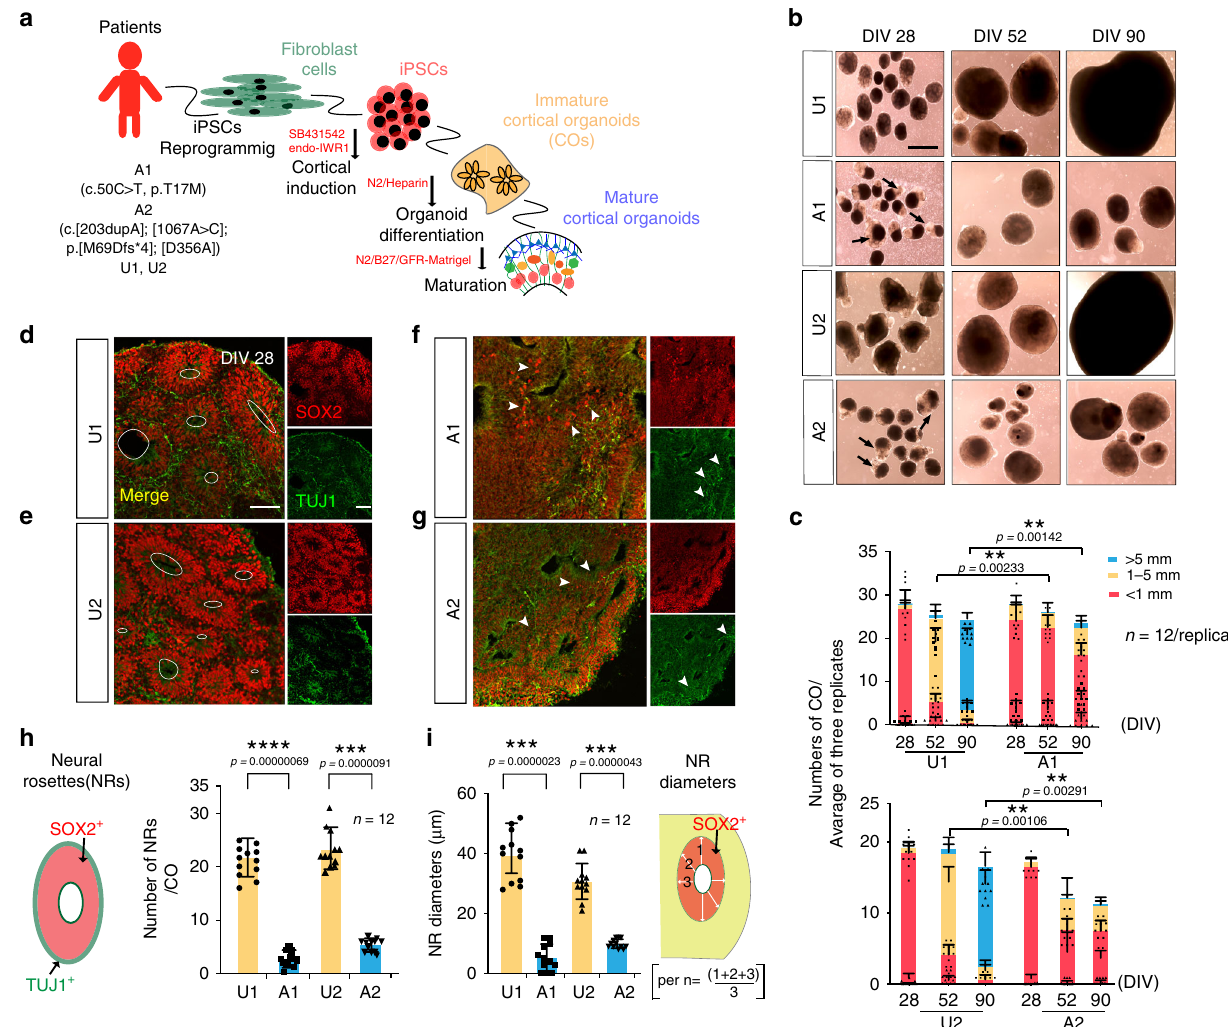
Fig. 3 NARS1 patient COs show reduced size and impaired differentiation. a Schematic of experimental work fl ow. b COs generated from iPSCs A1 and A2 showed reduced size compared with controls at DIV28, 52 and 90. Scale bar: 400 µ m. c . COs binned by diameter show impaired size in patients compared with controls. n = 12 ( n represents 3 independent biological replicates generated from iPSCs at different passages (<25), and four times technical replicates for each of the independent biological replicate), Student t- test with Holm – Š ídák multiple comparison correction was used to determine the two-tailed p value, ** p < 0.01. Error bar: ± SD; Data are presented as mean values ± SD. The exact p value was shown in Fig. 3c. d – g Impaired morphology and cellular expression in patient COs, based upon SOX2 and TUJ1 expression. Unaffected COs shown in ( d ) (U1), ( e ) (U2), affected shown in ( f ) (A1), ( g ) (A2). Dashed circle represents inner circumference of neural rosette. White arrowheads: small clusters of SOX2 + cells in mutant COs. Scale bar = 100 µ m; ( h ) Schematic and quanti fi cation for neural rosette numbers in ( d – g ). Neural rosettes were counted if they had a SOX2 + inner ring surrounded by a TUJ1 + outer ring. i Quanti fi cation and schematic of neural rosettes diameters of ( d – g ). Neural rosette diameters were measured at three different angles, set apart by 45° each, then averaged. For ( h ) and ( i ), n = 12 ( n represents 3 independent biological replicates generated from iPSCs at different passages (<25), and four times technical replicates for each of the independent biological replicate), Student t- test with Holm – Š ídák multiple comparison correction was used to determine the two-tailed p value, **** p < 0.000001, *** < 0.00001. Error bar: ± SD. Data are presented as mean values ± SD. Source data are provided as a Source Data fi